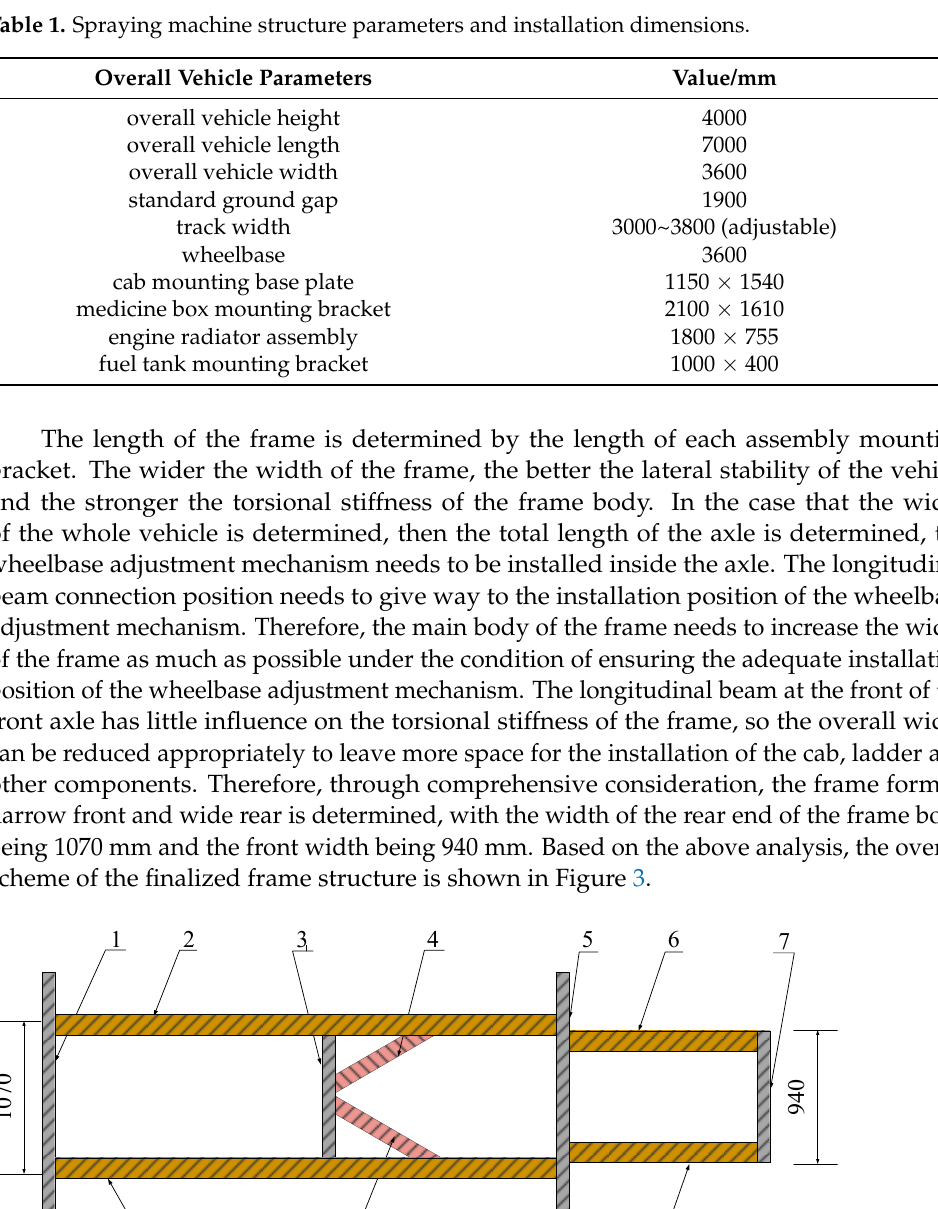
( c ) Figure 4. Longitudinal beam structure diagram. ( a ) Initial longitudinal beam section; ( b ) Slot cross- sectional drawing; ( c ) Stacked section diagram.